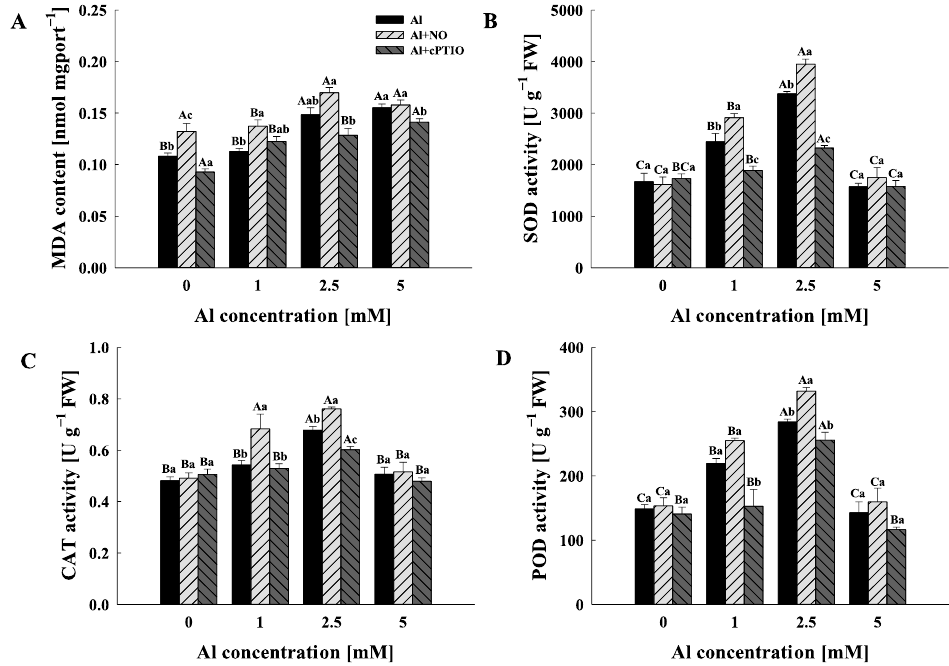
Figure 2. The effects of different treatments on the malondialdehyde (MDA) contents ( A ), superoxide dismutase (SOD) ( B ), catalase (CAT) ( C ) and peroxidase (POD) ( D ) activities of Camellia sinensis pollen tubes. FW: fresh weight. Al represents the treatment group treated with Al concentration gradient only, Al + NO represents the treatment group treated with Al 3+ concentration gradient treatment and 25 μM DEA NONOate (NO donor), and Al + cPTIO represents the treatment group treated with Al 3+ concentration gradient treatment and 200 μM carboxy PTIO potassium salt (NO scavenger). Different lowercase letters represent significant differences among different nitric oxide conditions under the same Al 3+ concentration treatment, and different uppercase letters represent significant differences among different Al 3+ concentration treatments under the same nitric oxide condition (n = 3, p < 0.05), as determined by the Duncan test.